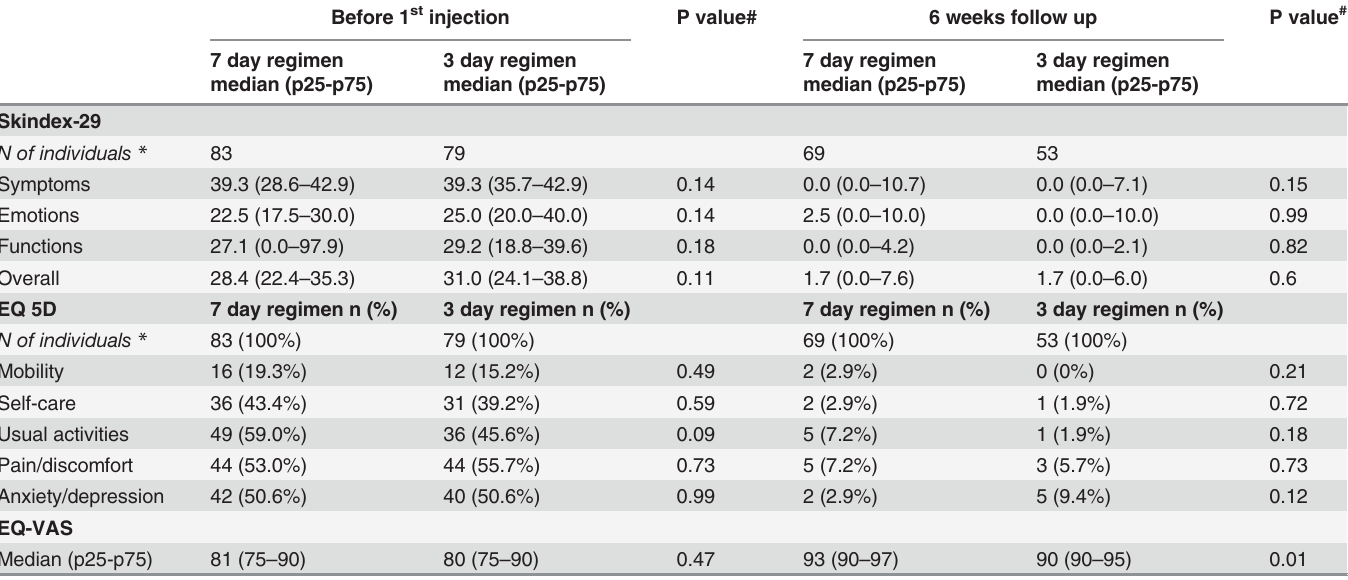
Table 3. Results of SKINDEX-29 and EQ-5D questionnaires on treatment visit 1 and follow-up visits 6 weeks according to treatment group of cuta- neous leishmaniasis patients in Suriname from 2010 –